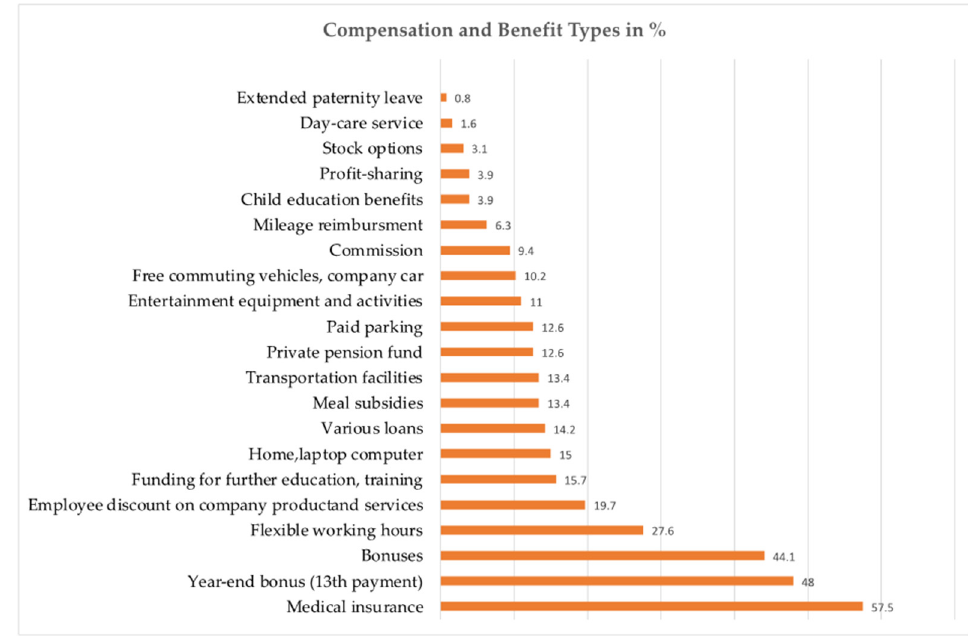
Figure 2. Percentage of employees receiving the types of compensation and benefits.